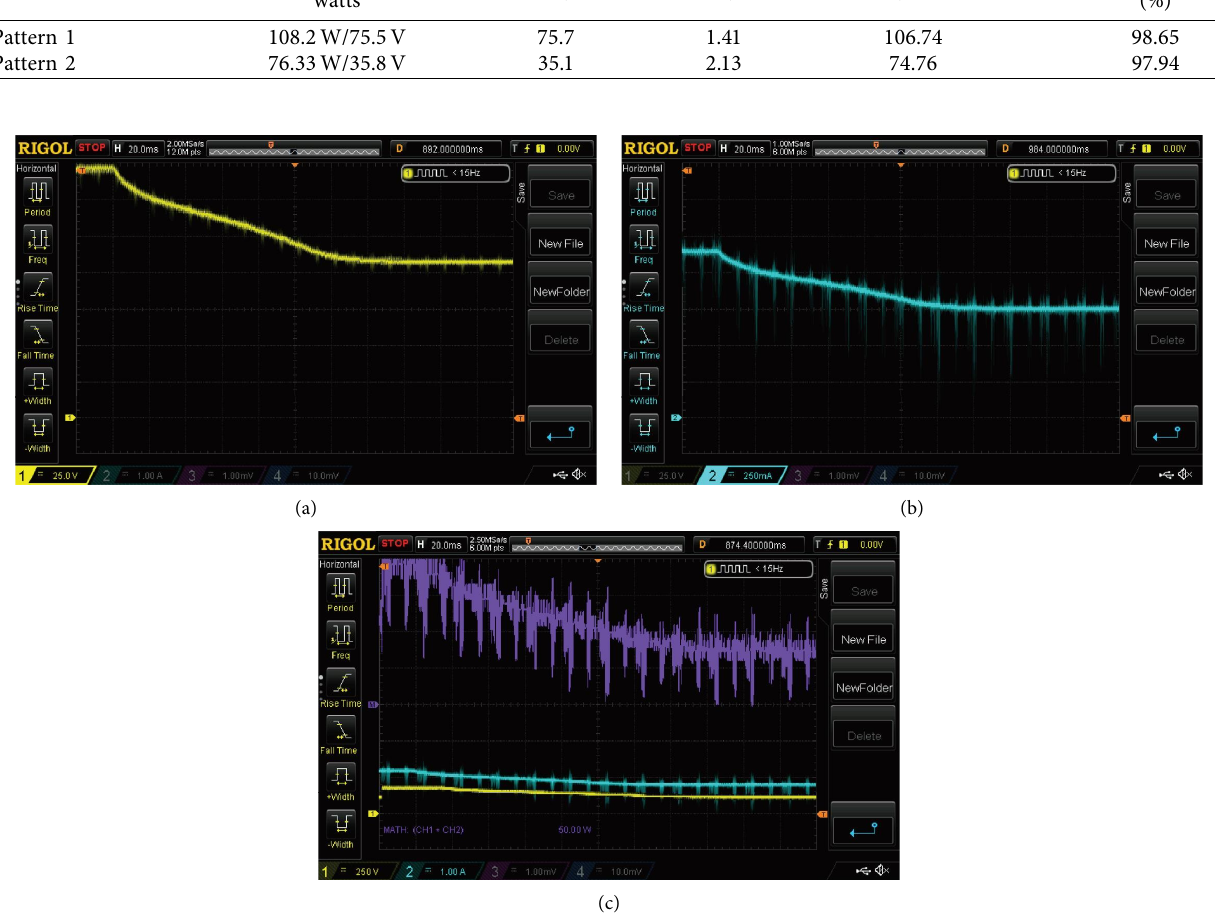
Figure 15: Experimental result of proposed GWO-ANFIS MPPTfor pattern 2. (a) DC link voltage. (b) DC link current. (c) DC link